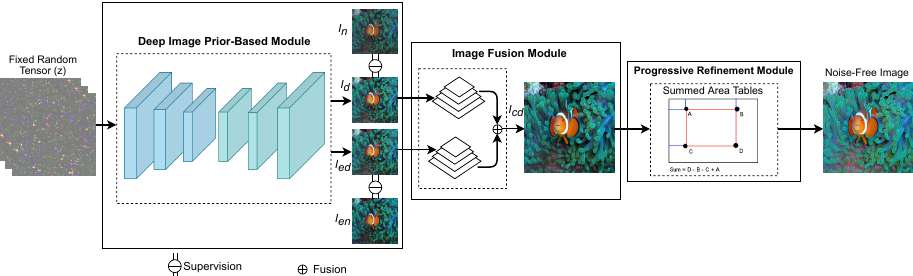
Figure 1. Flowchart of the proposed denoising method. I n is a noisy image, I en is an enhanced noisy image obtained by applying a contrast enhancement method to I n . I d and I ed represent two denoised images that are supervised by I n and I en ,